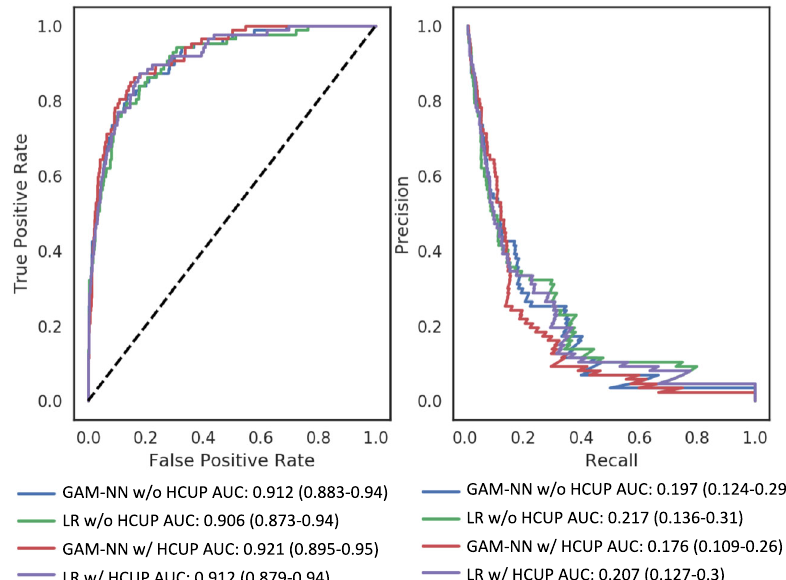
Fig. 1 Receiver operator characteristic curves and precision-recall curves for LR models and GAM-NN for prediction of mortality with and without HCUP features. GAM-NN: Generalized Additive Models with Neural Networks; HCUP: Healthcare Cost and Utilization Project; LR: Logistic regression.